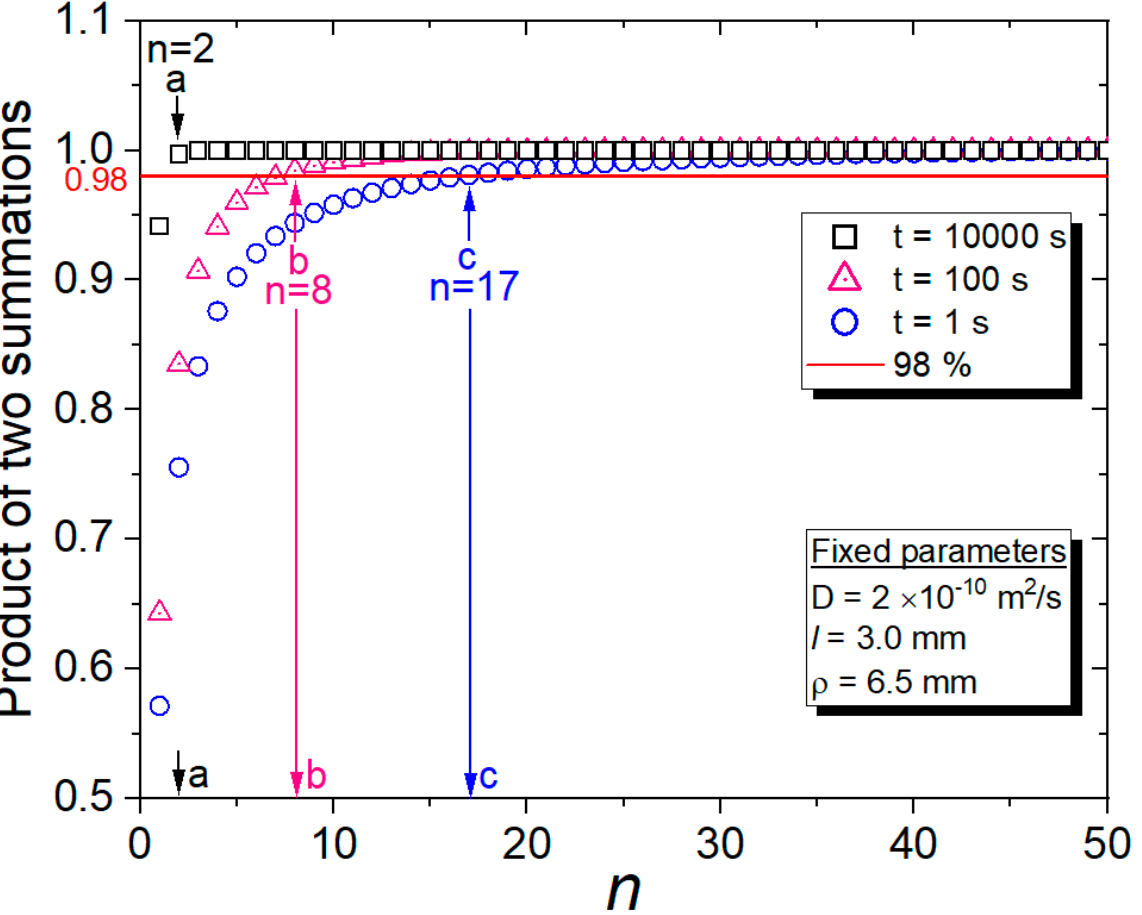
Figure 1. Product of two summations vs. n at different times.